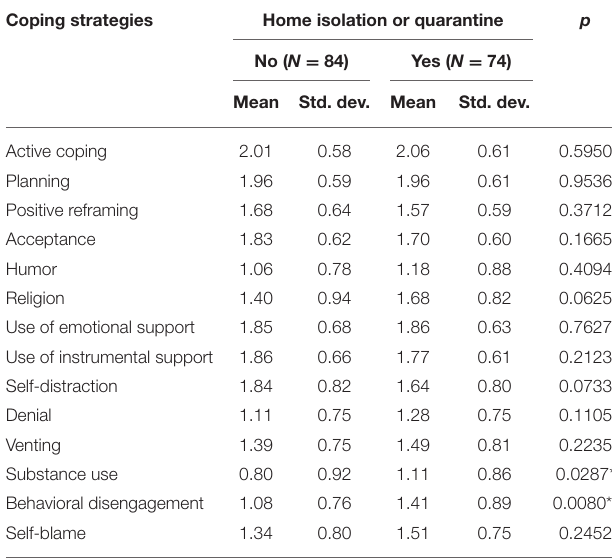
TABLE 7 | Active coping strategies among nurses in Belarus according to the COVID-19 pandemic elements and demographic factors. Independent variables